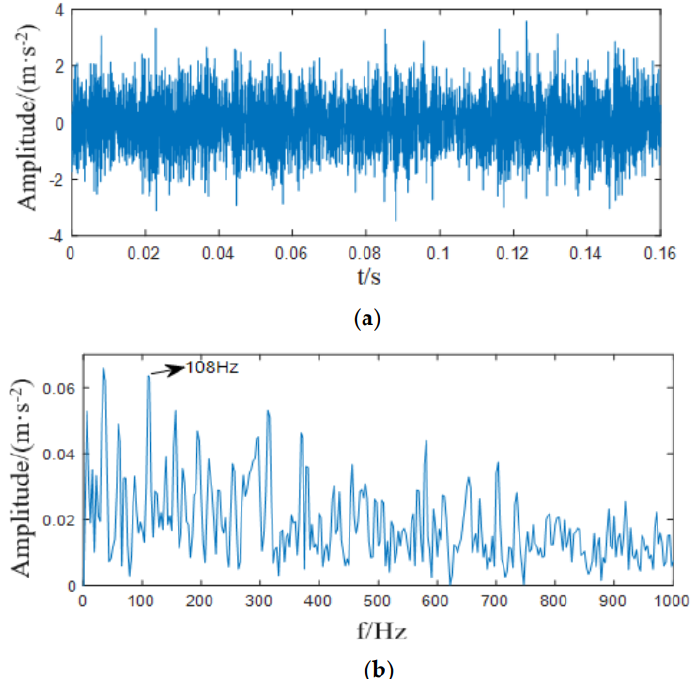
Figure 9. Time-domain diagram and envelope diagram of the experimental signal. (( a ) Time-domain diagram of experimental signal. ( b ) Experimental signal envelope.)